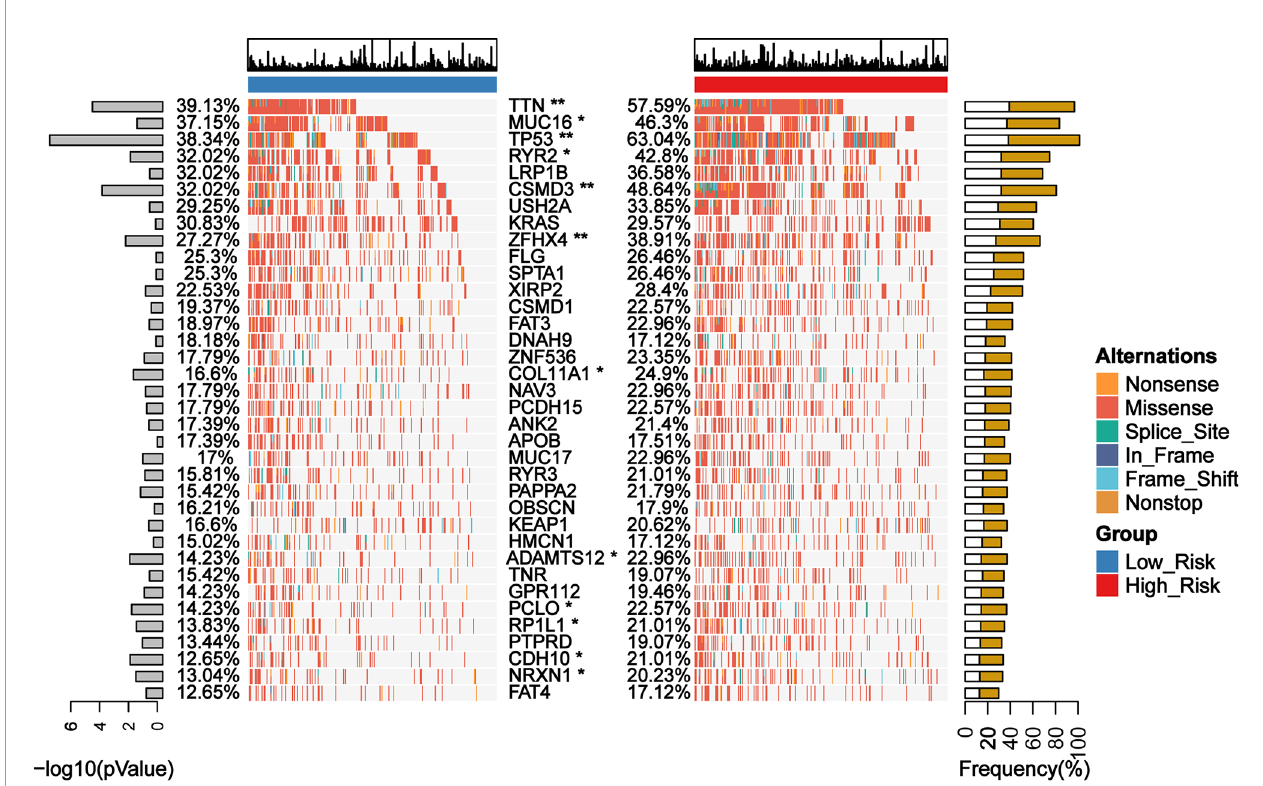
FIGURE 7 | Mutation landscape of genes with signi fi cant difference between low- and high-risk subgroups in TCGA LUAD cohort. *P < 0.05; **P <